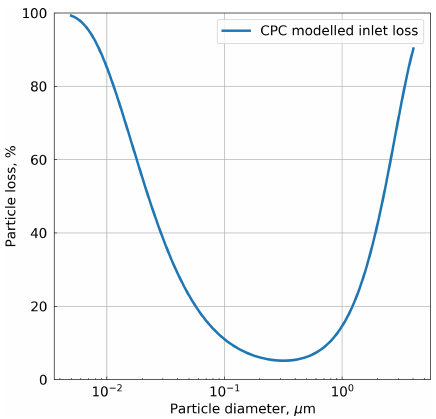
Figure 2. Modelled particle loss as a function of particle diameter in the CPC inlet, as estimated by the Particle Loss Calculator (von der Weiden et al.,